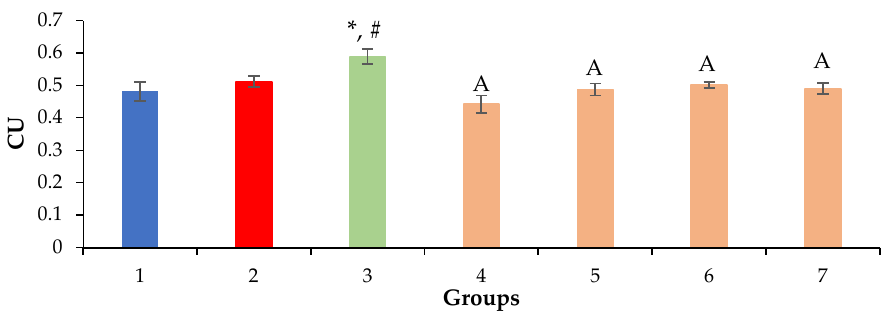
Figure 6. Volume density of hepatocyte cytoplasm. * p ≤ 0.05 as compared to the negative control; # p ≤ 0.05 as compared to the intact control; A p ≤ 0.05 as compared to silymarin 100 mg/kg. CU: conventional units; 1: intact control; 2: negative control; 3: positive control; 4: mice treated with QS-528 at a dose of 60 mg/kg; 5: mice treated with QS-528 at a dose of 90 mg/kg; 6: mice treated with QS-528 at a dose of 120 mg/kg; 7: mice treated with QS-528 at a dose of 150 mg/kg. The volume density of liver sinusoids after the administration of silymarin remained at the level of the negative control due to the preservation of the fibrotic process, which occurred mainly perisinusoidally (Figures 2 and 7). An increase in the volume density of liver sinusoids, on the contrary, was observed in the experimental groups due to the resolu- tion of small vesicular lipid degeneration and, as a result, a decrease in the compression of the sinusoidal lumen (Figures 3, 4 and 7).